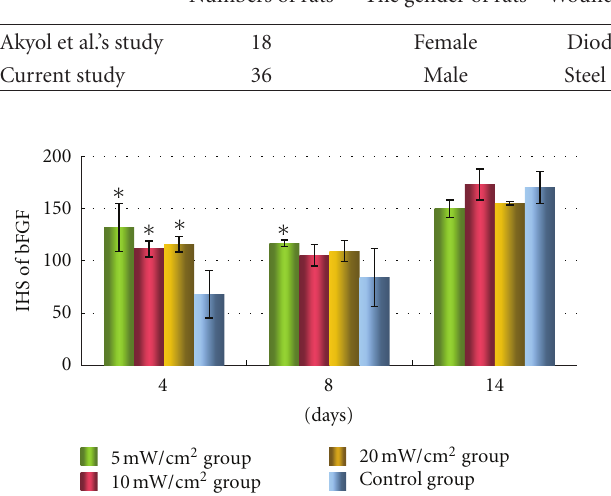
Figure 7: Immunohistochemical score (IHS) of bFGF protein expression throughout the experiment. Asterisk means that this group has statistical di ff erence with control group ( P < 0 . 05).